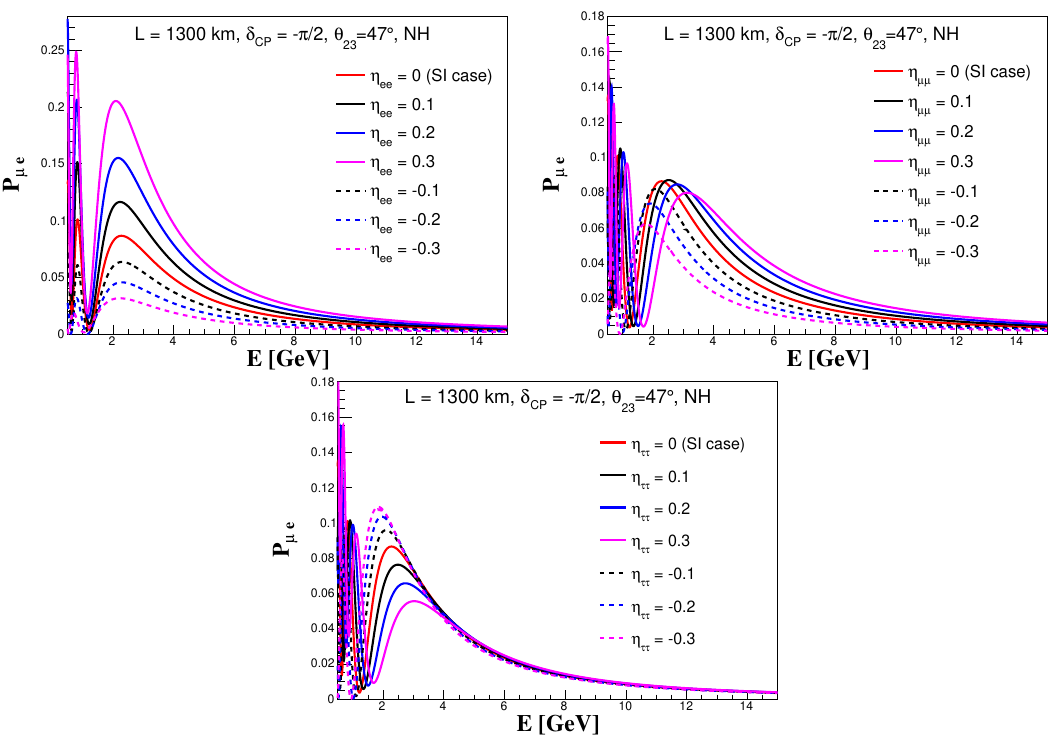
Figure 1 . The effects of η ee (top-left panel), η µµ (top-right panel), and η ττ (bottom panel) on P µe for δ CP = − π /2, θ 23 = 47 ◦ and NH. In every subfigure, the red-solid curve is for the SI case and the other solid (dashed) curves are for positive (negative) non-zero values of η αβ